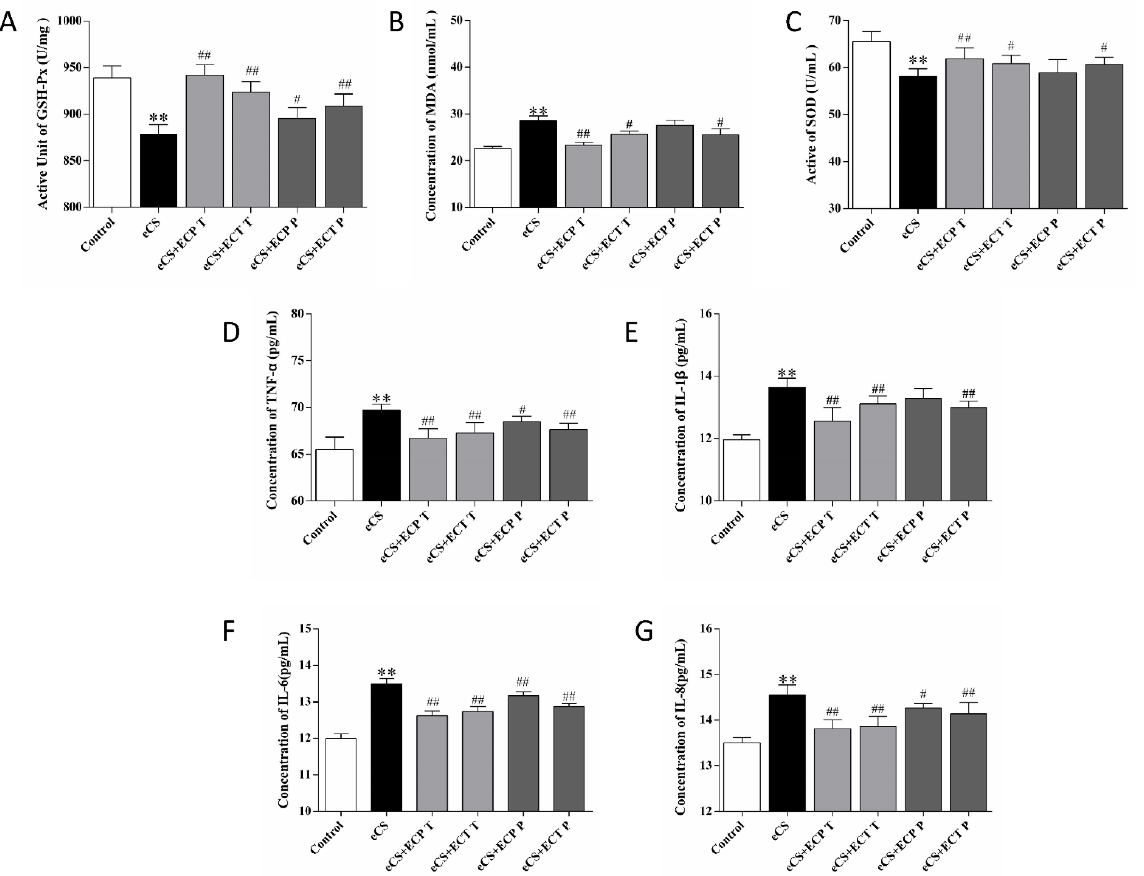
Figure 6. The effects of ECP and ECT on GSH-Px and SOD activities and the expression of MDA, TNF- α , IL-6, IL-8, and IL-1 β levels in serum of mice exposed to eCS. ( A ) Active unit of GSH-Px. ( B ) Activity of SOD. ( C ) Concentration of MDA. ( D ) Concentration of TNF- α . ( E ) Concentration of IL-1 β . ( F ) Concentration of IL-6. ( G ) Concentration of IL-8. The measures represent mean ± SD. **: compared with the blank control group, p < 0.01; #: compared with the eCS model group, p < 0.05; ##: compared with the eCS model group, p <